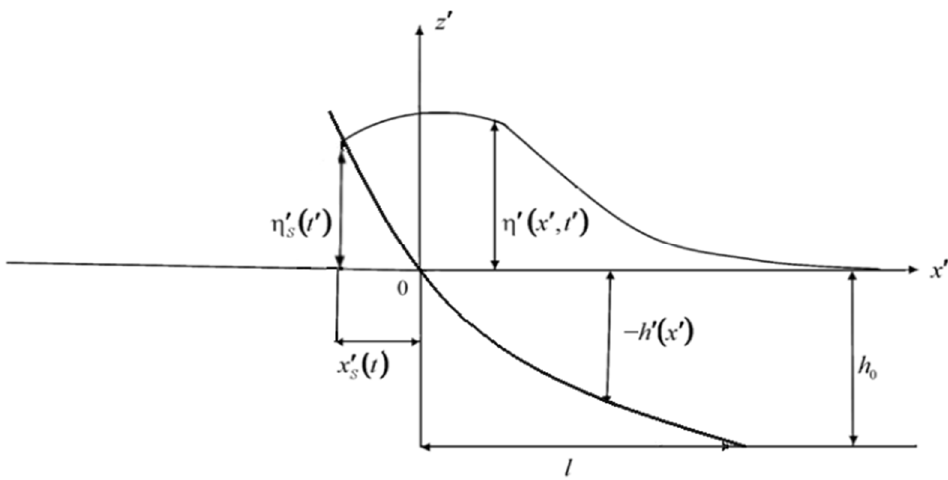
Figure 2. A schematic of the runup phenomenon used in the current paper.